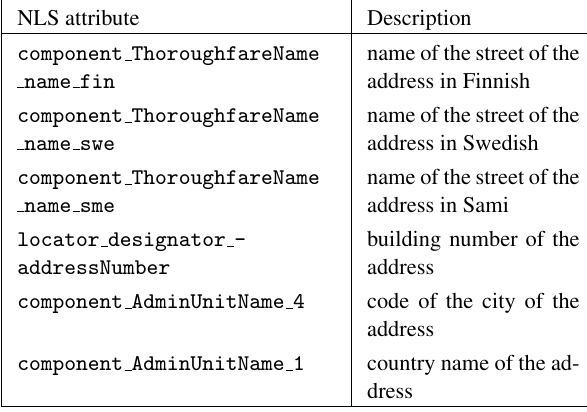
Table 2: Address-related NLS